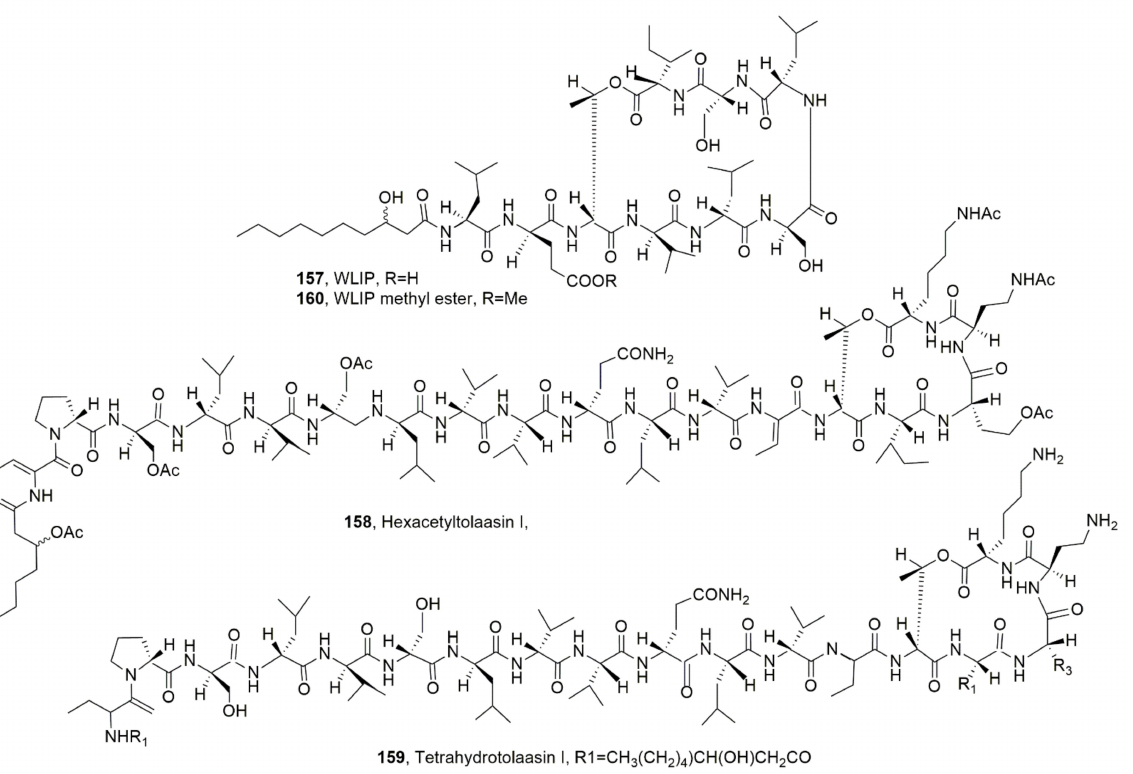
Figure 18. Structure of WLIP produced by Pseudomonas reactans and its methyl ester ( 157 and 160 ) and the hexacetyl- and tetrahydro-derivative of tolaasiin I ( 158 and 159